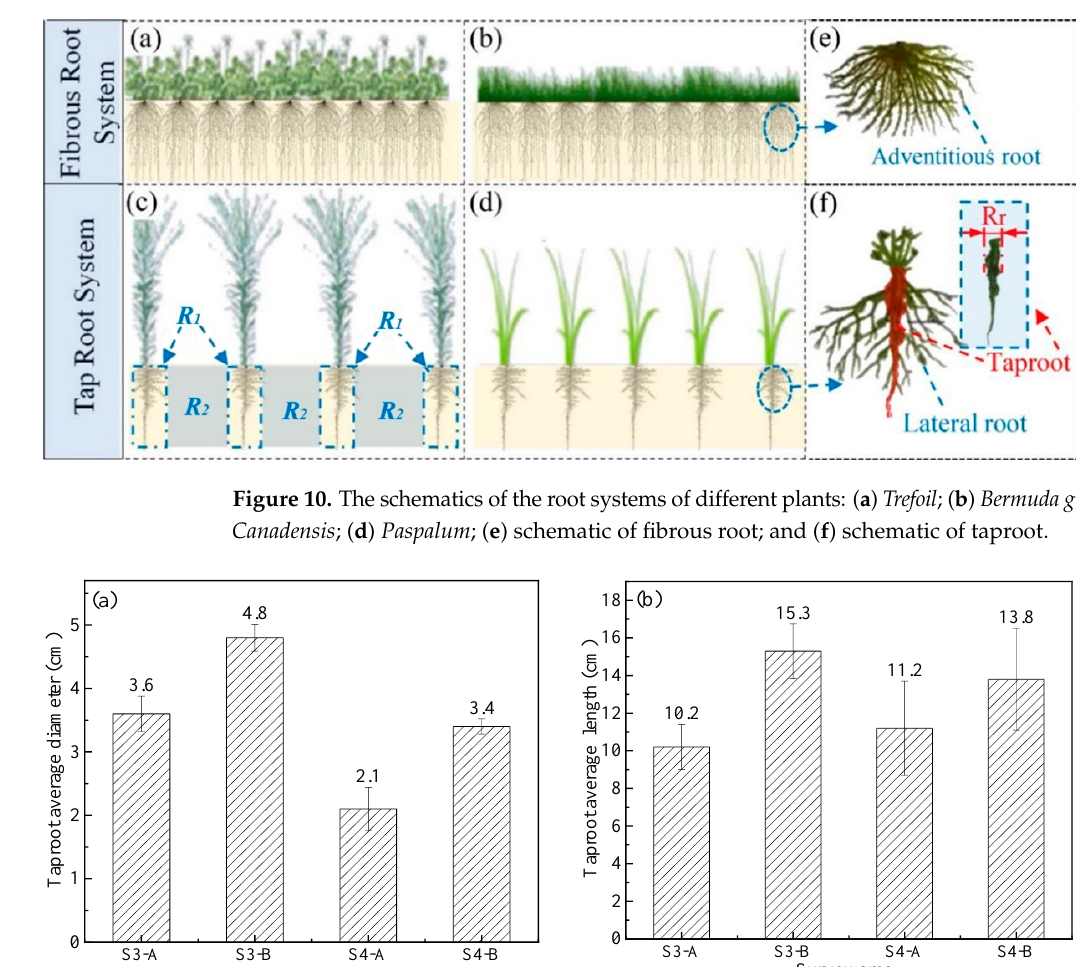
Figure 8. The schematic effects of plant distribution on crack distribution: the relationship between the crack degree and plant distribution.